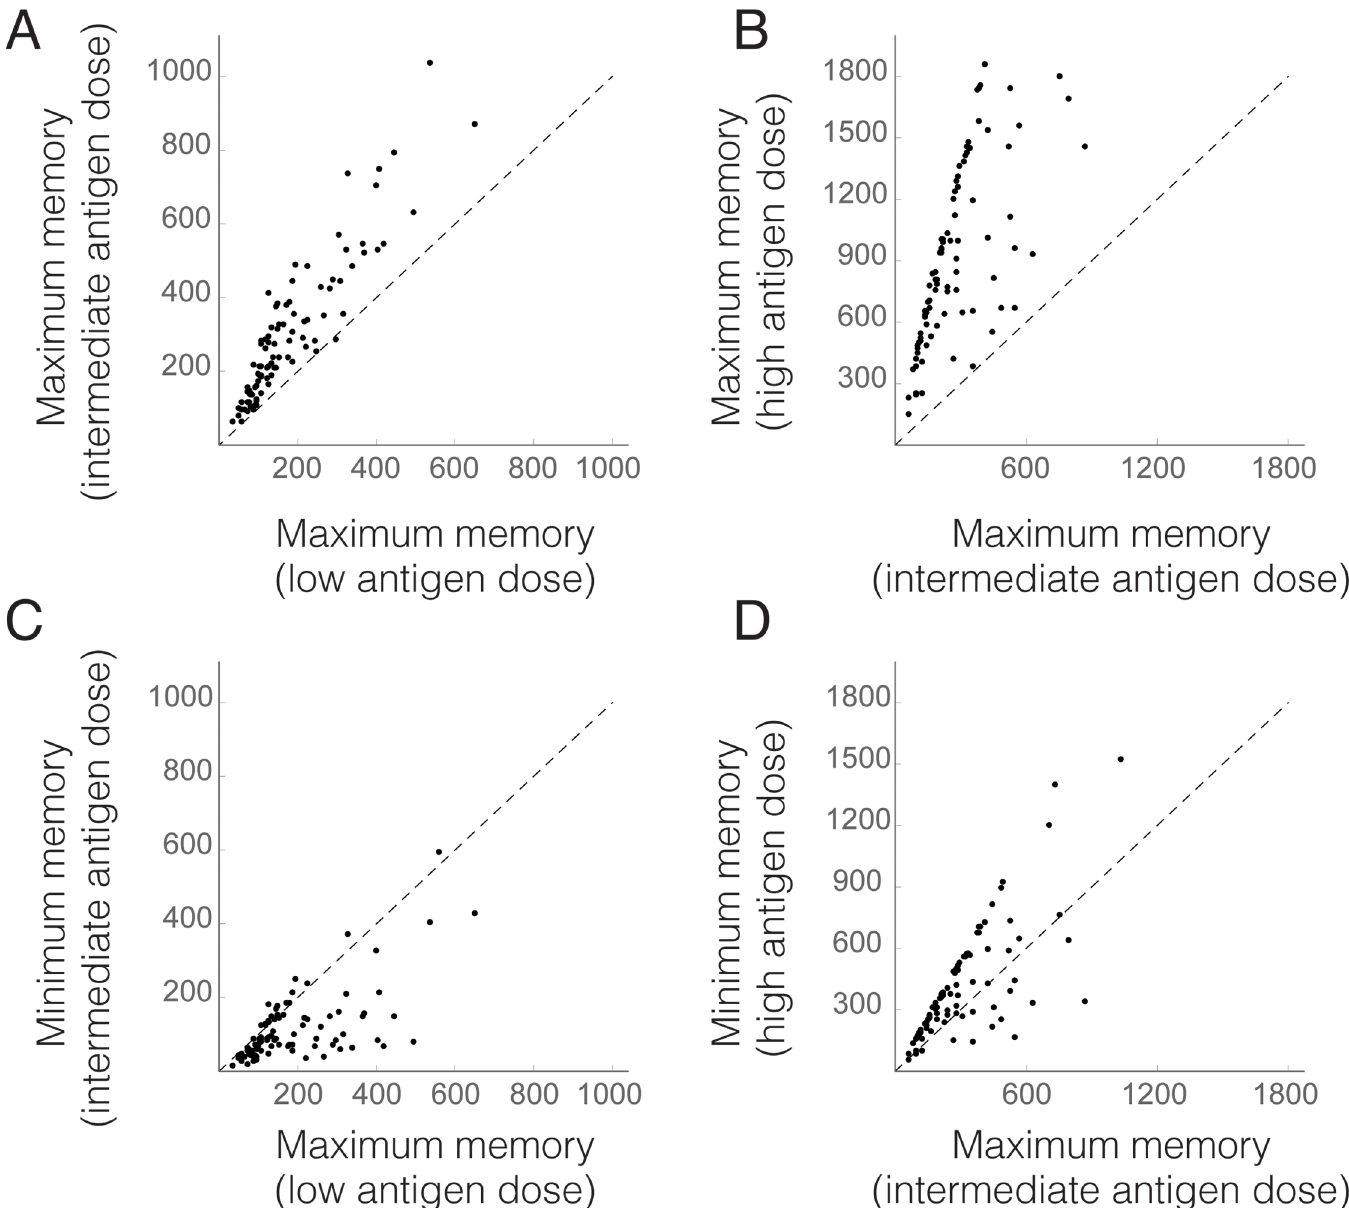
Fig 5. Comparison of maximum and minimum number of memory T cells formed in PB vaccines using different total antigen doses. Performance of PB protocols defined as described in Fig 4 for low, intermediate and high vaccine doses (the rest of parameter values are randomly chosen as in Fig 4). A) Each dot represents the maximum number of memory T cells for PB protocols with low and intermediate antigen doses. All the dots are above the line of equation x = y (dashed line), which implies that it is possible to produce more memory T cells with intermediate than with low antigen doses. B) Same as in A for intermediate vs high antigen doses. C,D) The maximum number of memory T cells produced with lower antigen doses can be larger than the minimum of memory T cells created when higher antigen doses are used.